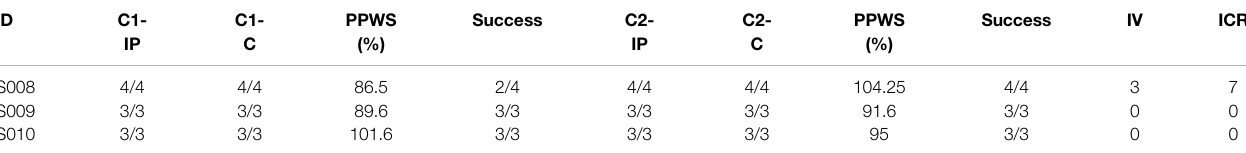
TABLE 5 | C1 and C2 mean the different crosswalk. IP means initial pose estimation. C is success of classi fi cation of signs. The PPWS is the percentage preferred walking speed of mean of trials. IV is the number of intervention in the entire tests by assistants. The ICR indicates the number of incorrect responses by users.